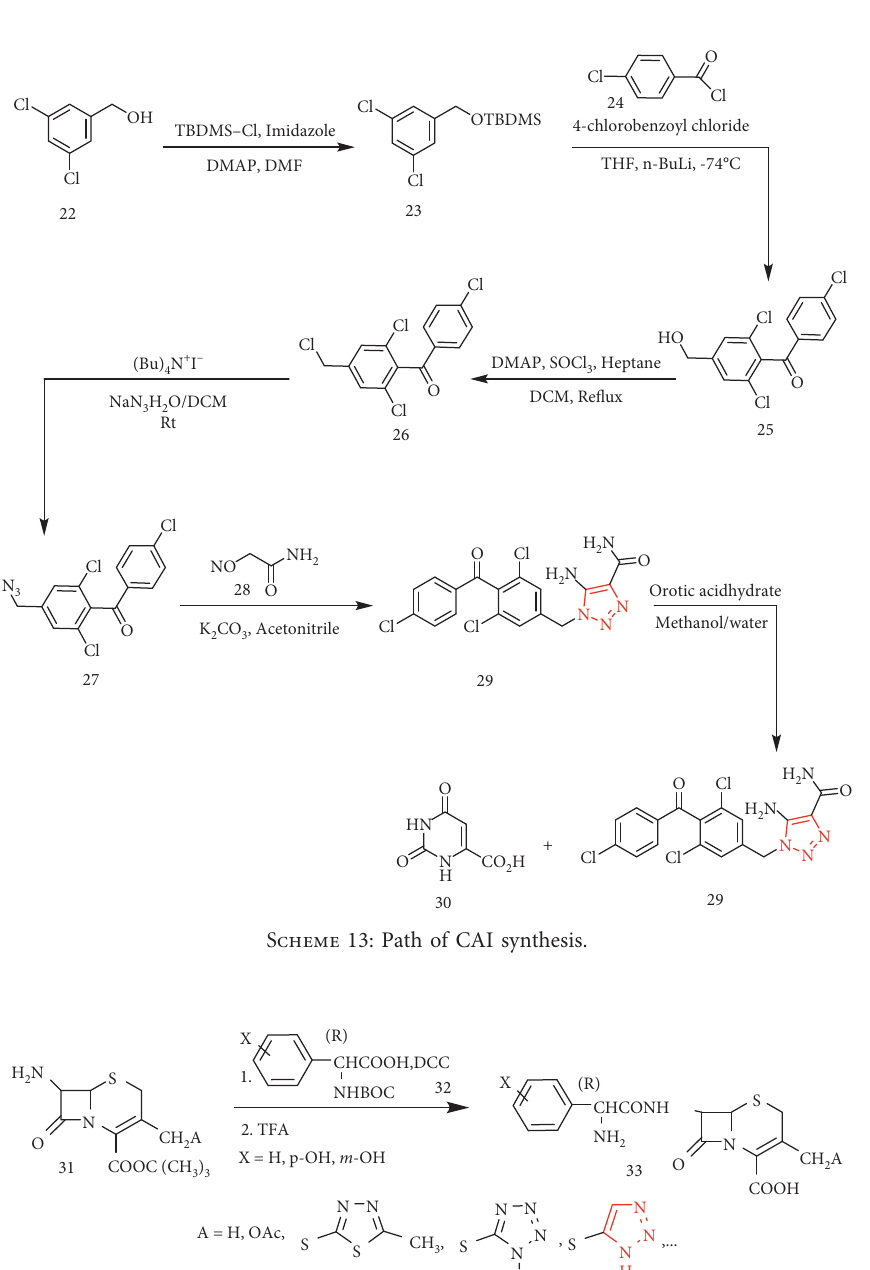
Scheme 14: Path of Cefatrizine